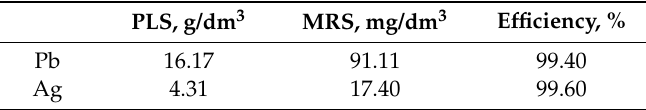
Table 8. Pb and Ag concentration of PLS and